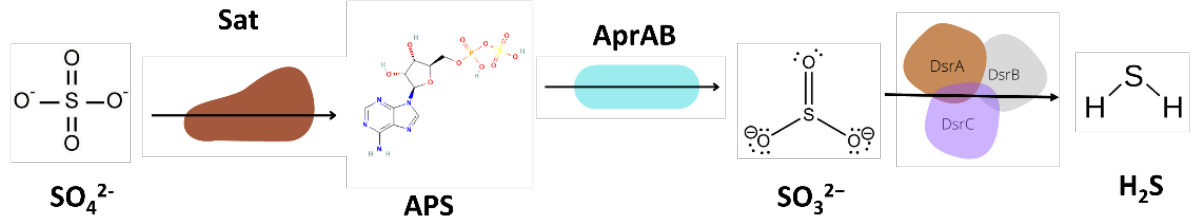
Figure 6. Summary of dissimilatory sulfate reduction pathway in SRB. Activation of sulfate to APS is carried out by the enzyme sat and further reduced by AprAB to sulfite. The final reduction of sulfite to hydrogen sulfide (H 2 S) is derived by the enzyme DsrABC .